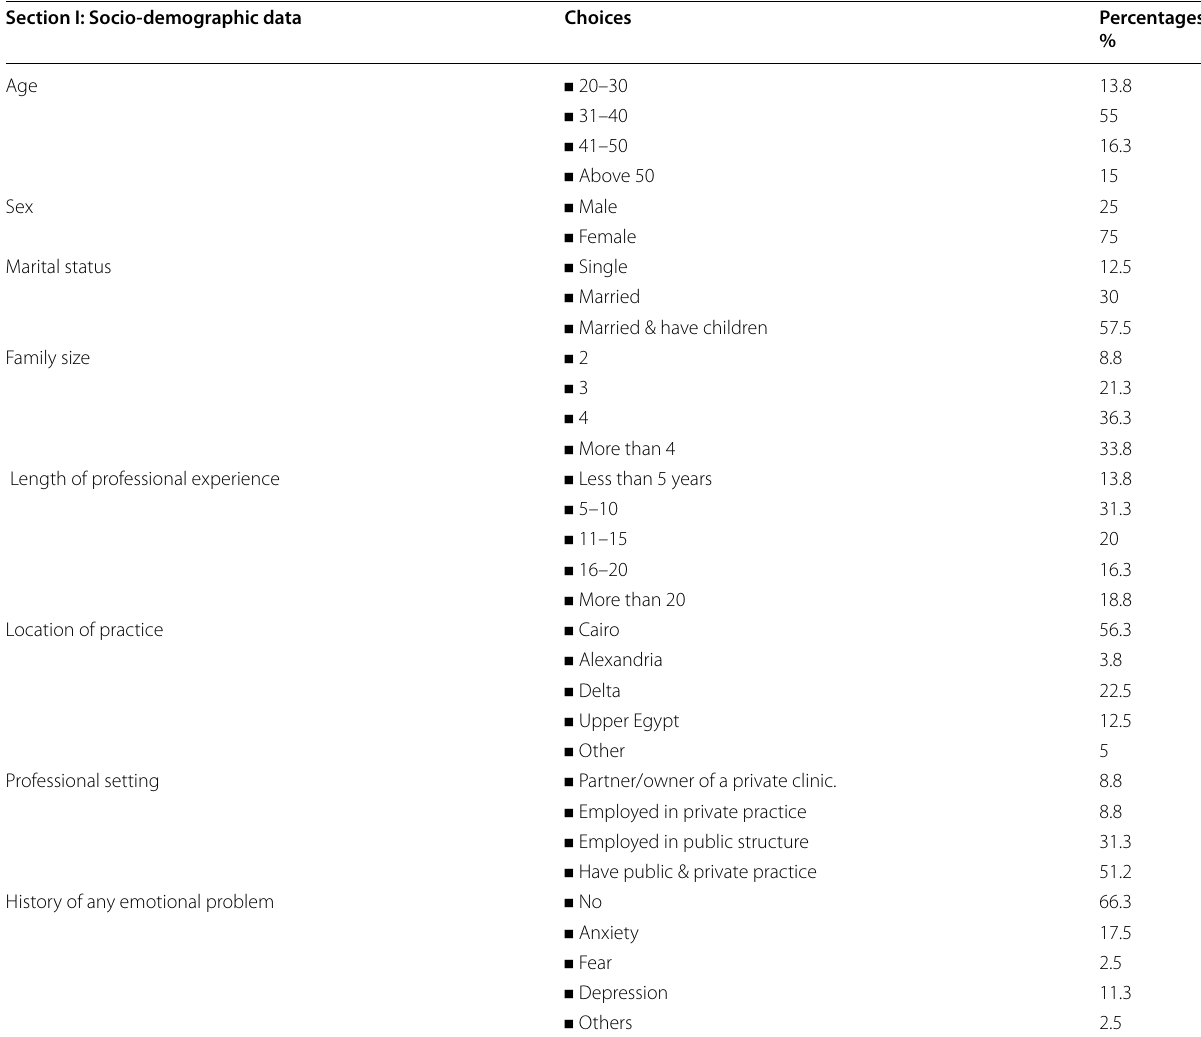
Table 1 The percentages of the socio-demographic data of the studied group Section I: Socio-demographic